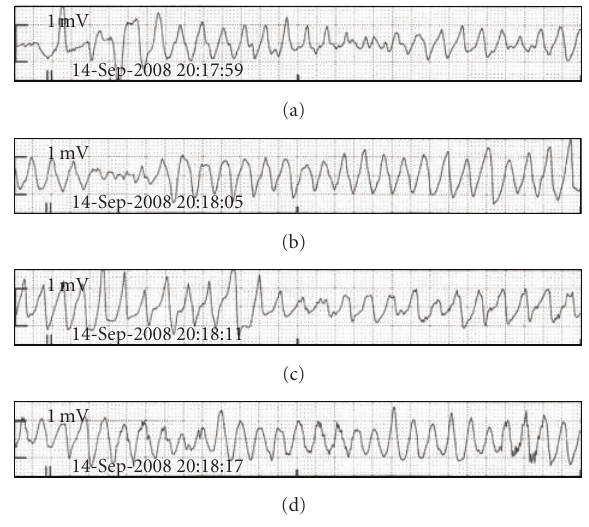
Figure 2: ECG appearance of Torsades de Pointes